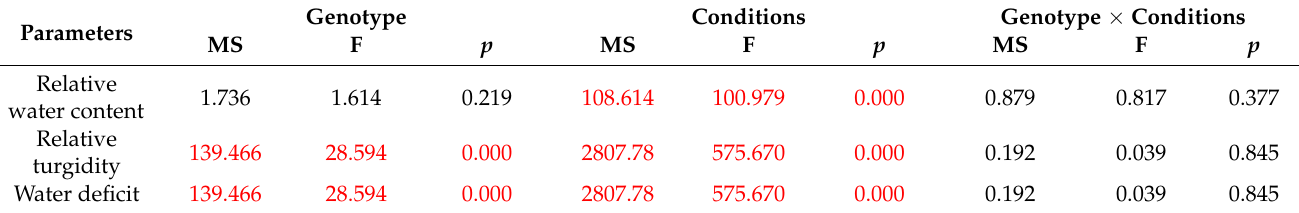
Table 3. Results of two-way ANOVA for two barley genotypes (Golden Promise and Haruna Nijo) grown under two conditions (control conditions and salt stress induced by 150 mM sodium chloride) were calculated for aboveground and belowground organ traits (length; FW, fresh weight; DW,